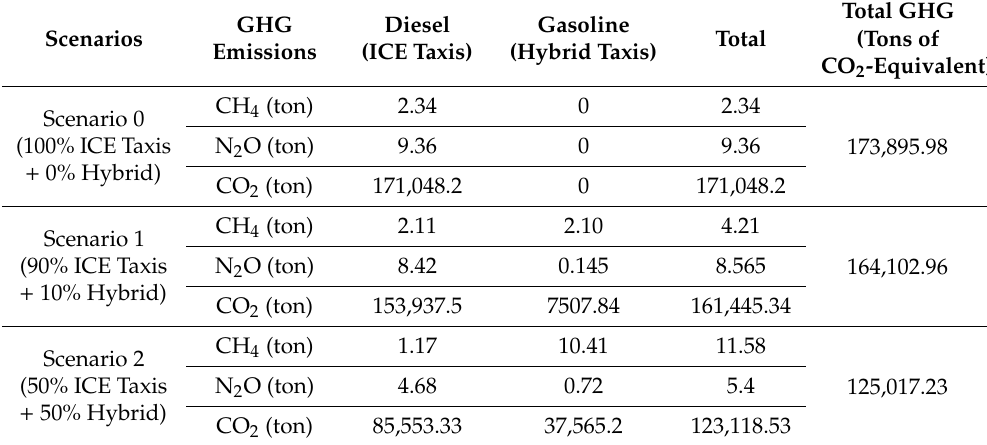
Table 4. Estimated GHG emissions by taxis in 2030.